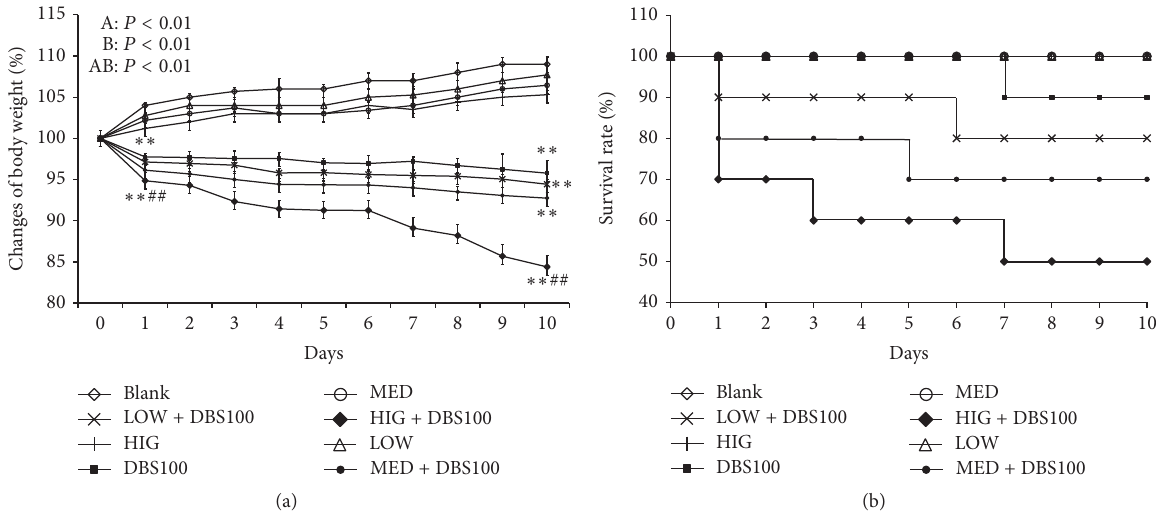
Figure 5: The impact of 𝜅 -carrageenan on weight loss and the mortality with Citrobacter freundii DBS100-stimulated inflammation. (a) Weight changes in percentage. (b) Survival ratios. 𝜅 -Carrageenan was orally administered for 1 week prior to bacterial inoculation. Infection was performed by oral gavage with 10 9 CFU/mouse of C. freundii DBS100. After ten days, the weight and the survival rate of the animals were recorded. Repeated measures ANOVA was used to measure differences between the groups for A; differences over time for B and differences between the interaction of experiment and time for AB shown. ANOVA and LSD post hoc test were used to examine pairwise comparisons between the groups at individual time points. ∗∗ 𝑃 < 0.01 , compared with the blank group. ## 𝑃 < 0.01 , compared with the C. freundii DBS100- treated